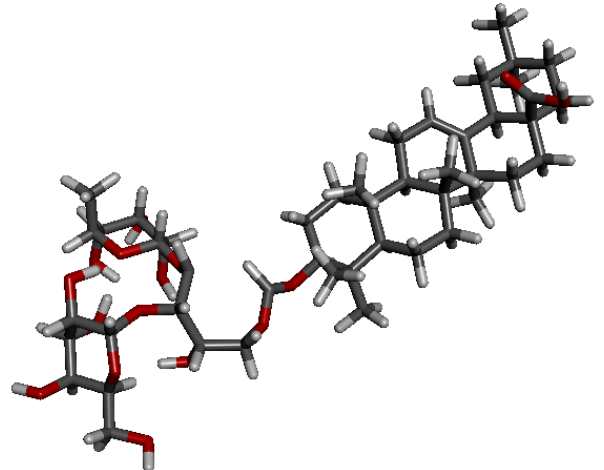
Figure 3. The transition state